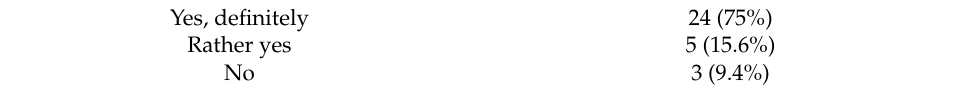
Table 3. Questionnaire-based survey related to a comparison between care units for patients infected with or suspected as infected with SARV-COV-2 in the AmberExpo temporary hospital and other medical